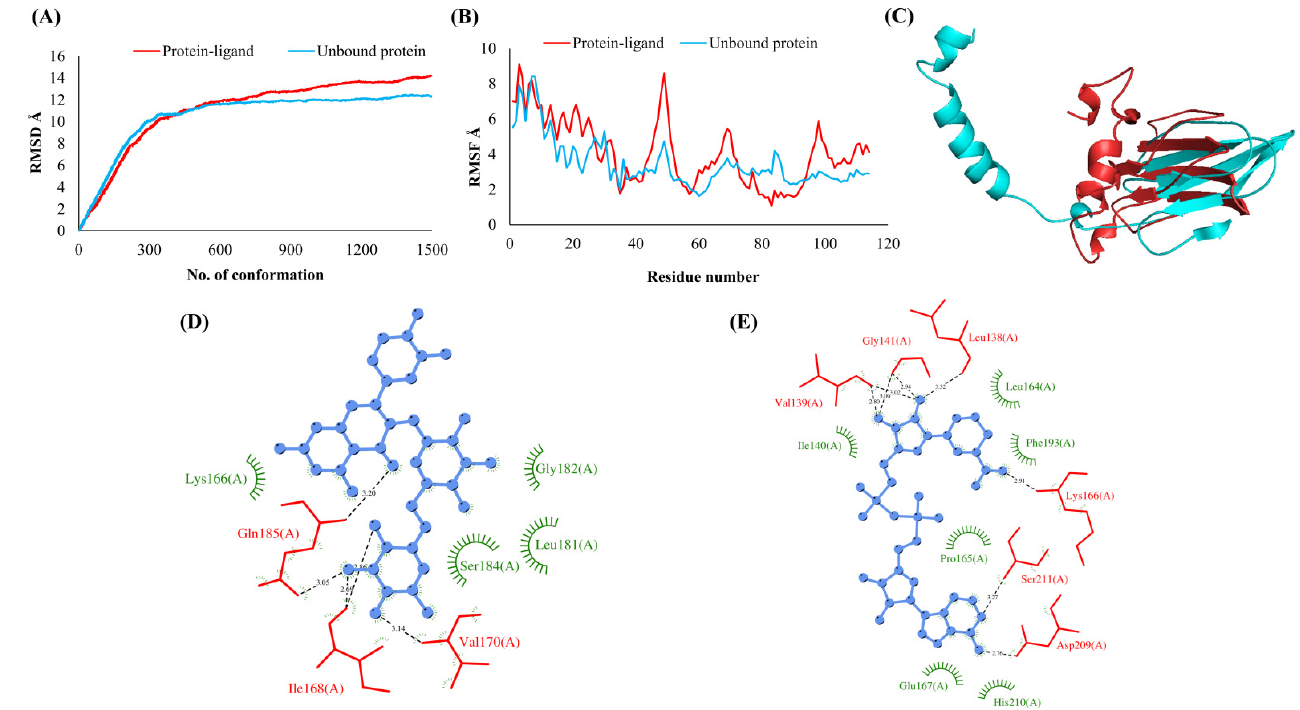
Figure 11. Membrane (M). ( A ) RMSD plot of unbound and ligand-bound protein ( B ) RMSF plot of unbound and ligand-bound protein ( C ) Superimposition of unbound and ligand-bound protein ( D ) Molecular interactions of protein with Rutin ( E ) Molecular interactions of protein with NADH.